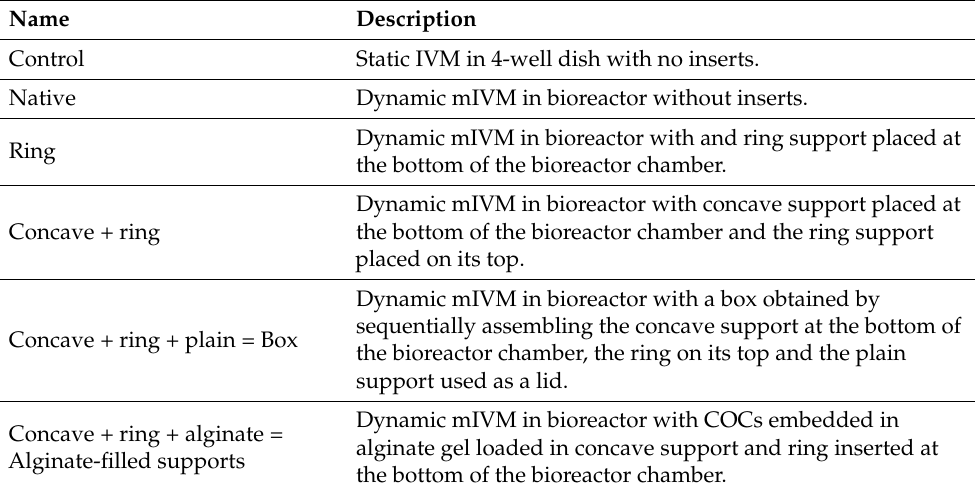
Table 1. Nomenclature of used millifluidic IVM (mIVM) culture